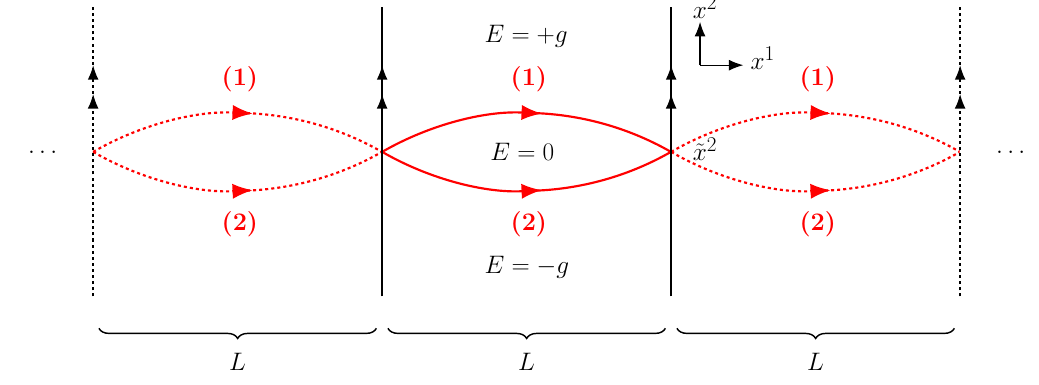
Figure 15. The single-lemon instanton (5.45), (5.46) contributing to h + g | − g i